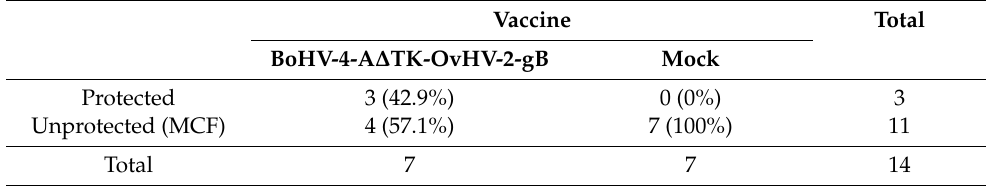
Table 1. Protection rate of a BoHV-4-A ∆ TK-OvHV-2-gB vaccine following OvHV-2 lethal challenge in a rabbit